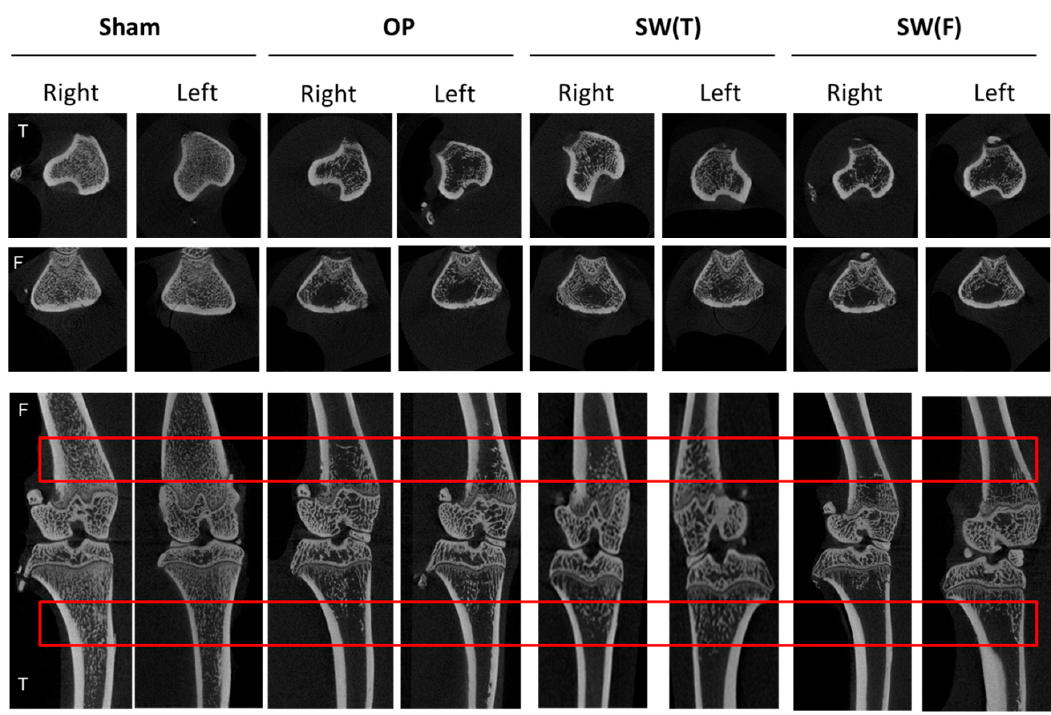
Figure 2. Micro-CT scans of different groups: the results are displayed on photomicrographs of the left and right knee in transverse (tibia and femur, up) and sagittal (femur and tibia, below) views obtained using micro-CT scanning. The volume of interest (VOI) region contained within the red line denotes the area of inspection. N = 6. The tibia is denoted T, and the femur is denoted F.